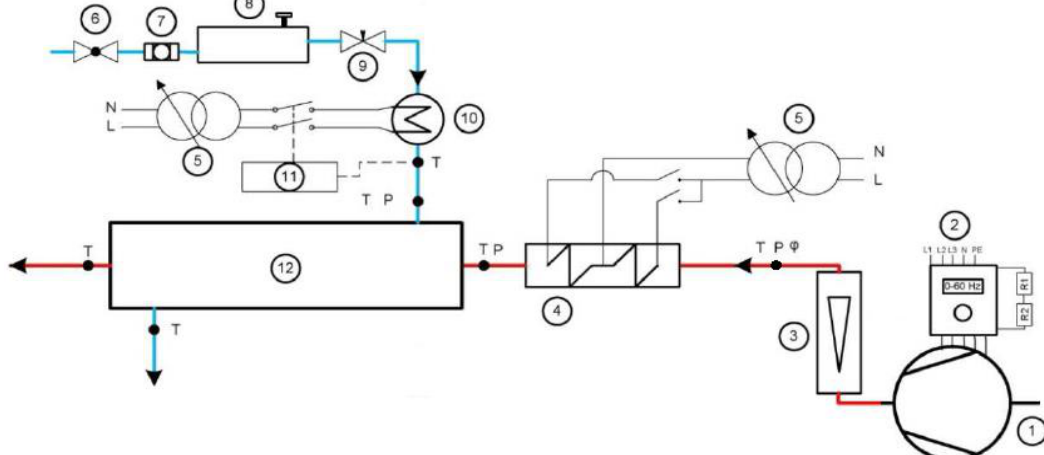
Figure 3. Diagram of the system; 1 — radial fan, 2 — inverter, 3 — rotameter, 4 — air heater, 5 — autotransformer, 6 — main water valve, 7 — filter, 8 — mass flowmeter, 9 — throttling valve, 10 — water heater, 11 — relay regulator, 12 — heat exchanger.